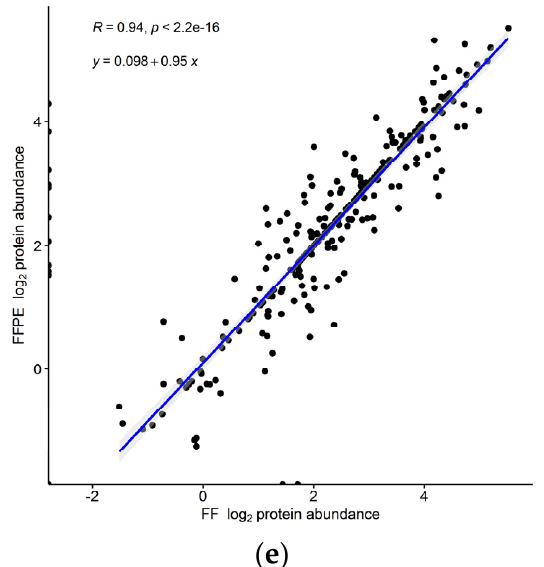
Figure 4. Comparison of NSAF values according to physicochemical properties of the identified proteins from 4 μ m thick FF and FFPE tissue after the extraction with Buffer 2 according to: ( a ) M W , ( b ) pI, ( c ) GRAVY scores, and ( d ) cellular localization. NSAF values are expressed as a percentage of total proteins; results are shown as mean ± SD; ( e ) correlation of the protein abundance for pro- teins detected with Buffer 2 in 4 μ m thick human kidney FF and FFPE tissues.